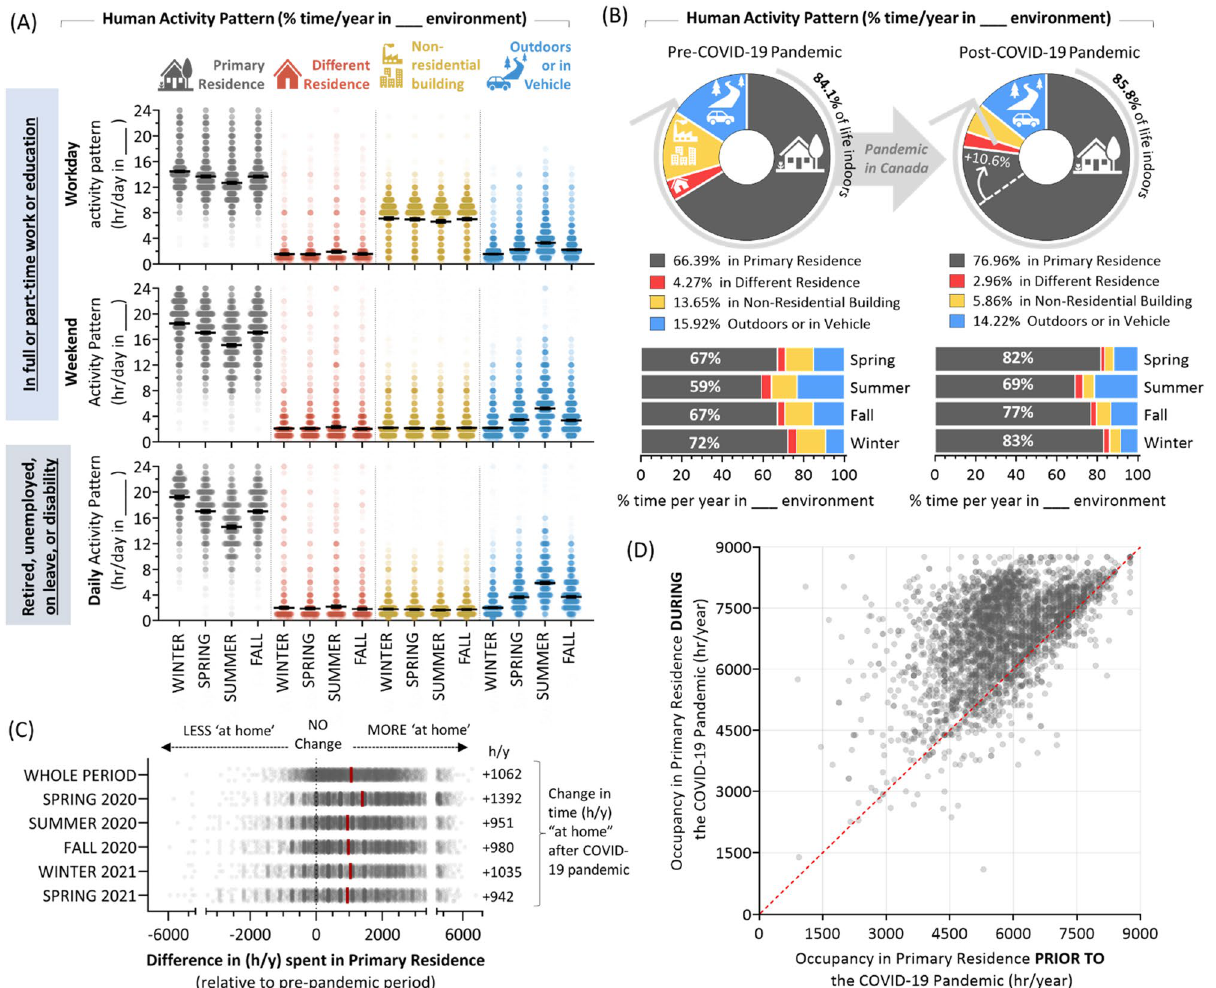
Figure 2. Canadian activity patterns before and after the onset of the COVID-19 pandemic. Panel A . For the pre-pandemic period, the number of hours per day spent across different environments including the primary residence (grey), a different residential building (red), any non-residential building type (yellow), or in a vehicle or outside (blue), as a function of seasons. Bars represent arithmetic means. For those in work or education, workdays were distinguished from weekends (including holidays). Panel B . Using the data in ( A ), the percent of time per year in each environment for the entire year (pie chart), or by season (bar charts) for the pre-COVID-19 pandemic period (a typical year prior to March 2020), and post-COVID-19 pandemic periods. Panel C . The absolute difference in hours spent in the primary residence relative to the pre-pandemic period. Red bars represent arithmetic mean h/y differences. Panel D . Scatter plot showing h/y that individuals spent in their primary residence prior to (x-axis) or during (y-axis) the COVID-19 pandemic. Figures were prepared using Excel and GraphPad Prism 9.1.1 (225) (www. graph pad.